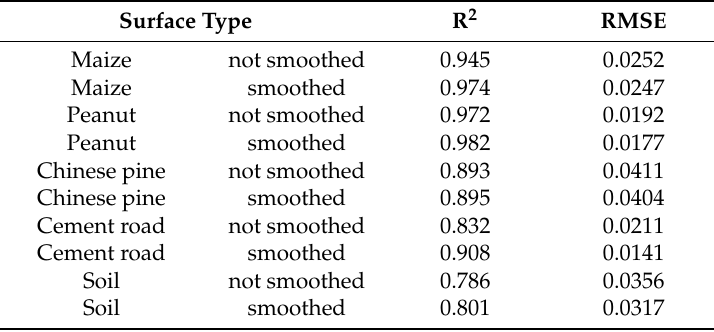
Table 4. Comparison of R 2 and RMSE between the retrieved surface reflectance from airborne images and at-ground